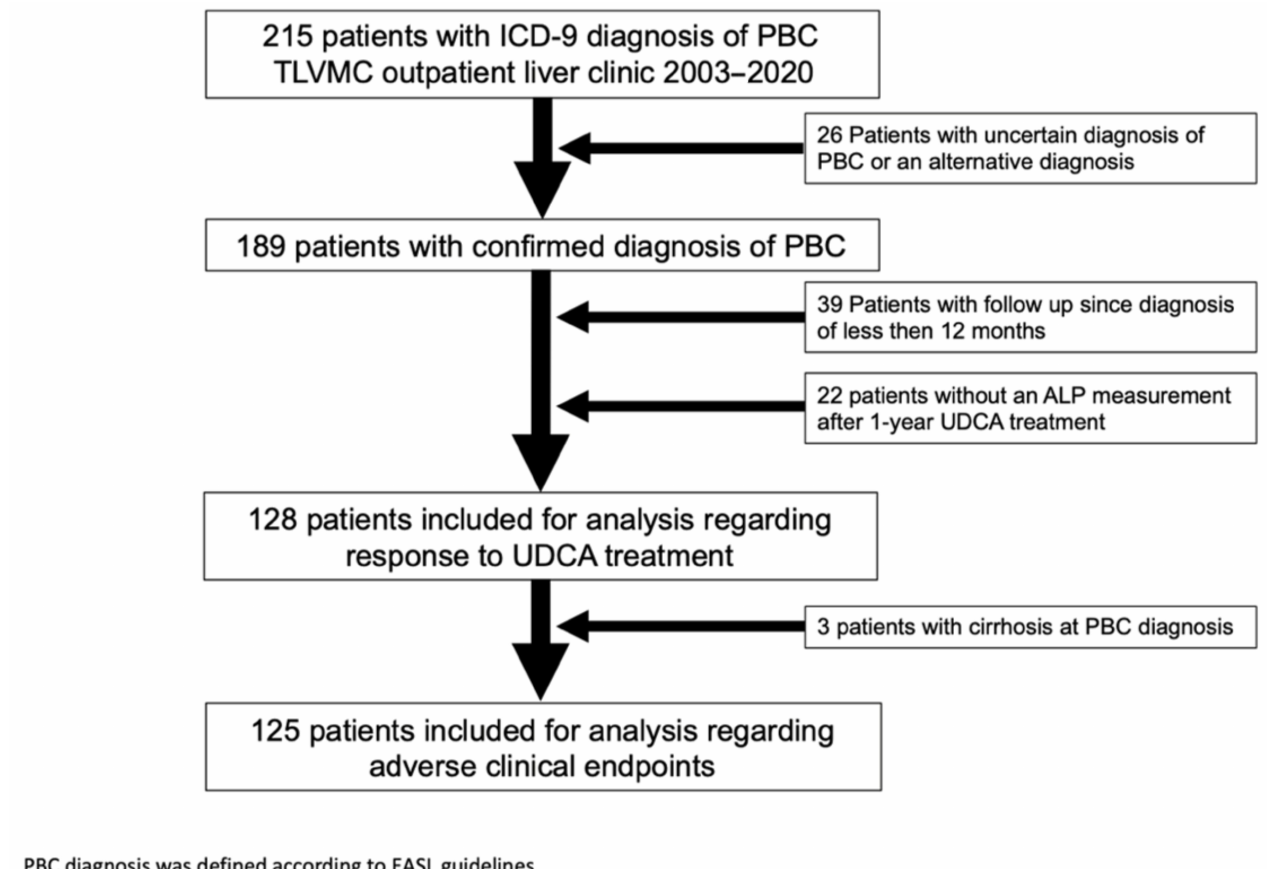
Figure 1. Study flow diagram. ICD, The International Classification of Diseases; PBC, primary biliary cholangitis; TLVMC, Tel Aviv Sourasky Medical Center; UDCA, ursodeoxycholic acid; ALP, alkaline phosphatase; EASL, European Association for the Study of the